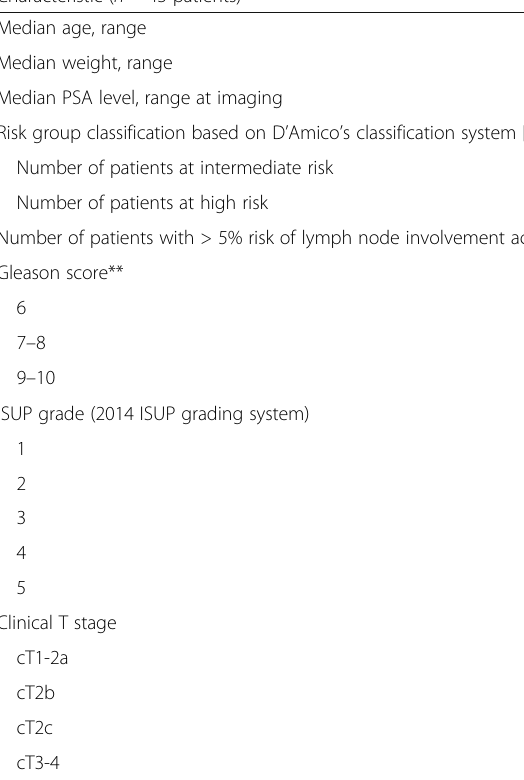
Characteristic ( n = 43